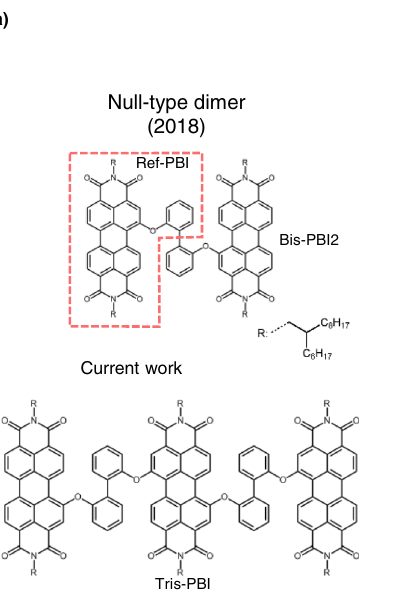
spectra of Ref-PBI (top), Bis-PBI2 (middle) and Tris-PBI (bottom) in TOL upon photoexcitation at500, 510,and 550nm, respectively. The red arrow indicates the red-edge band of Tris-PBI